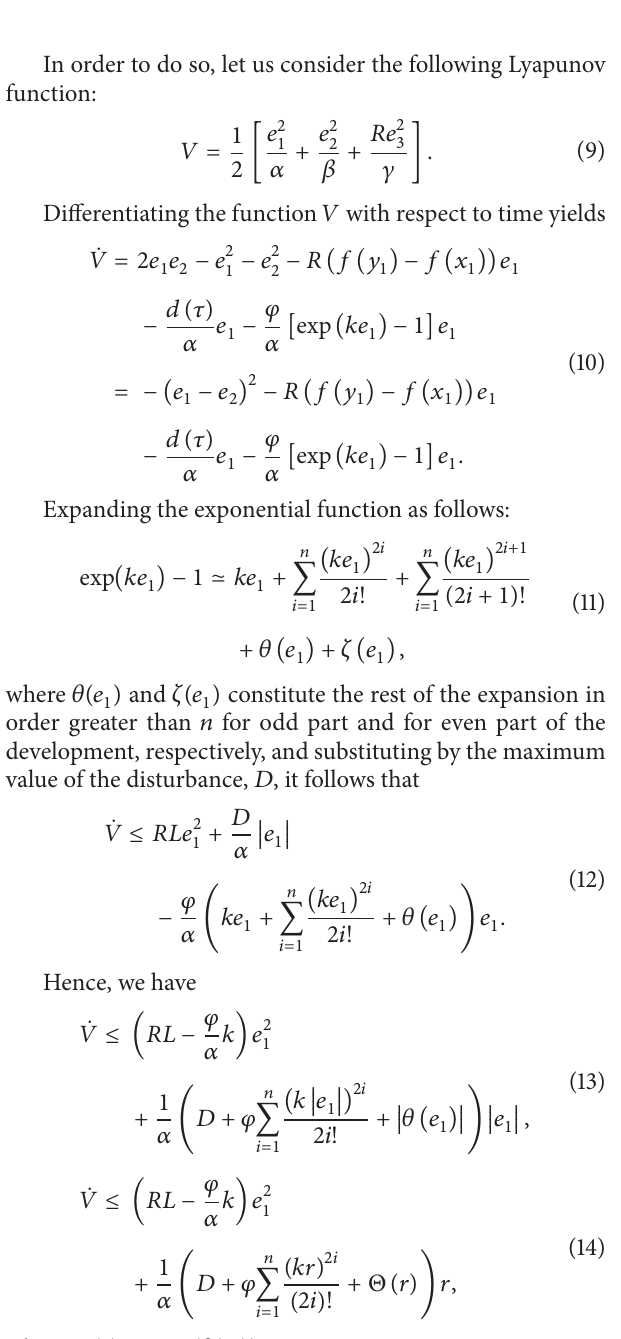
Figure 2: 3D chaotic attractor of the tunnel diode based modified Chua’s